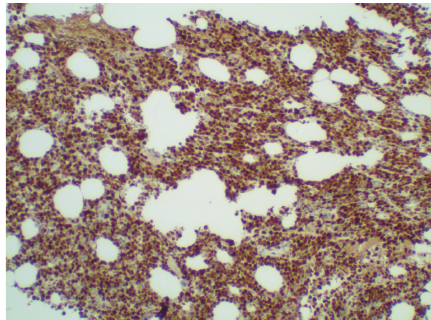
Figure 4: TdT staining abundant cells in bone marrow.